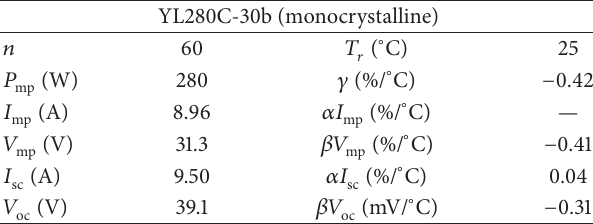
Table 1: Characteristic points of YL280C-30b solar panel (Yingli Solar), included in the manufacturer’s datasheets [ ref ] at